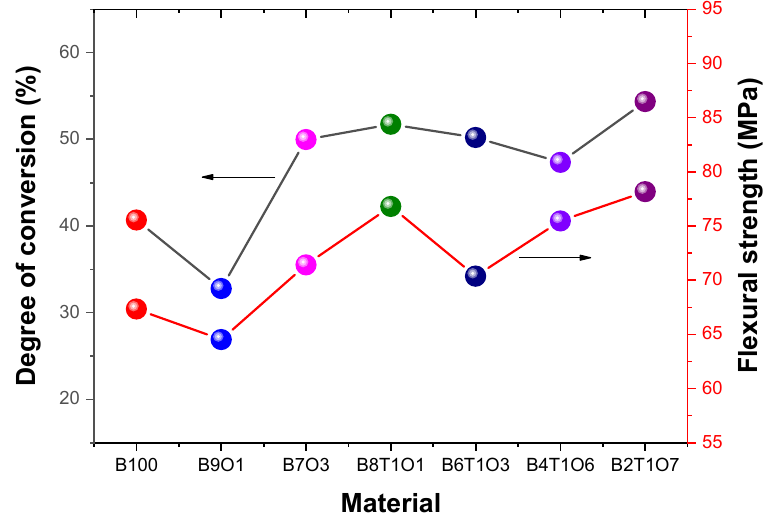
Figure 4. Degree of conversion and flexural strength of the 3D-printed specimens.